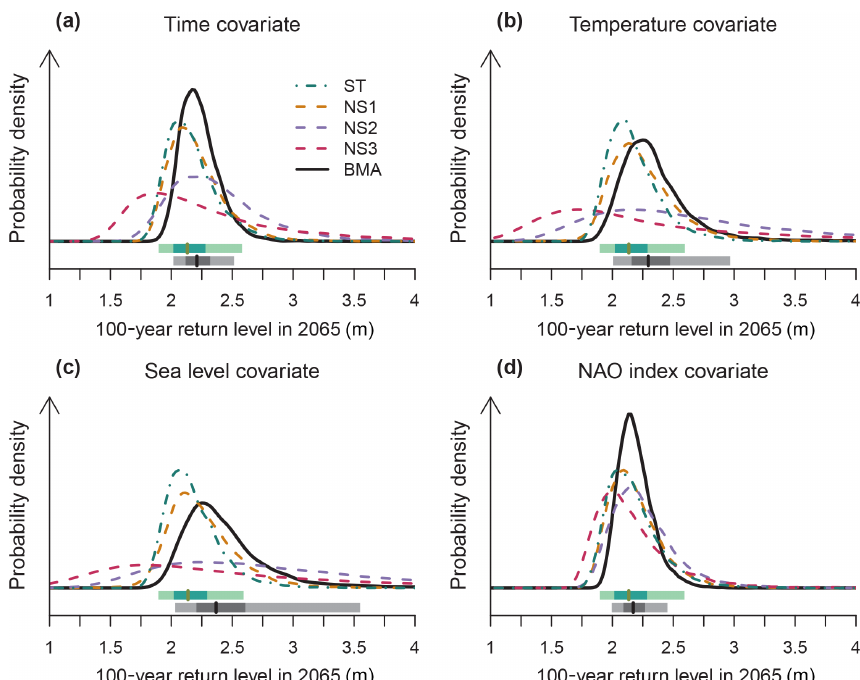
Figure 2. Empirical probability density functions for the 100-year storm surge return level (meters) at Norfolk, Virginia, as estimated using one of the four candidate model structures and using the Bayesian model averaging ensemble. Shown are nonstationary models where the statistical model parameters covary with (a) time, (b) global mean surface temperature, (c) global mean sea level and (d) winter mean NAO index. The bar plots provide the 5%–95% credible range (lightest shading), the interquartile range (moderate shading) and the ensemble medians (dark vertical line), for both the stationary model (green) and Bayesian model averaging ensemble (gray).